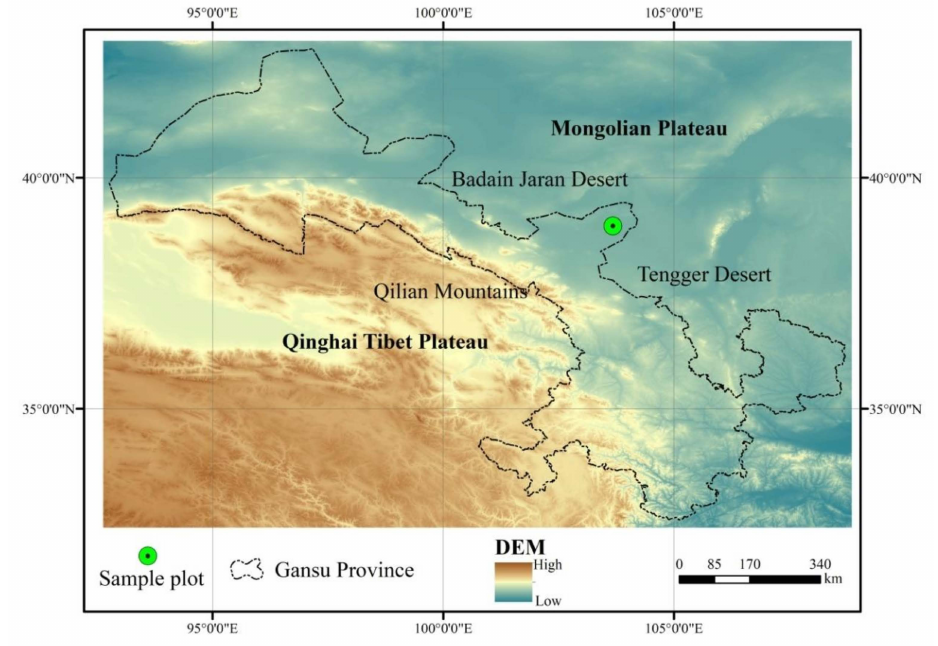
Figure 1. Location of the study area.